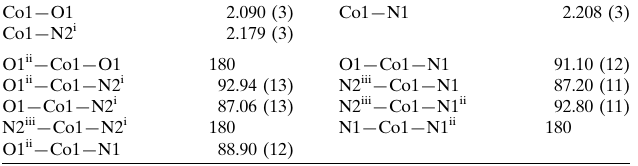
Selected geometric parameters (A˚ , (cid:2) ).